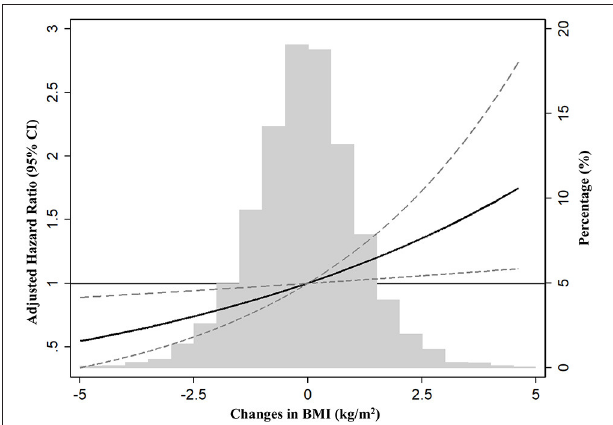
FIGURE 2 | Restrict cubic spline analysis for risk of incident chronic kidney disease (CKD) by changes in BMI (%). HR was expressed after adjustment of covariates, including age, sex, the area of residence, smoking, alcohol consumption habit, income, education levels, body mass index, mean arterial pressure, hemoglobin, albumin, fasting glucose, estimated glomerular filtration rate, high-density lipoprotein-cholesterol, triglyceride, and high-sensitive C-reactive protein. BMI, body mass index; CKD, chronic kidney disease; CI, confidence